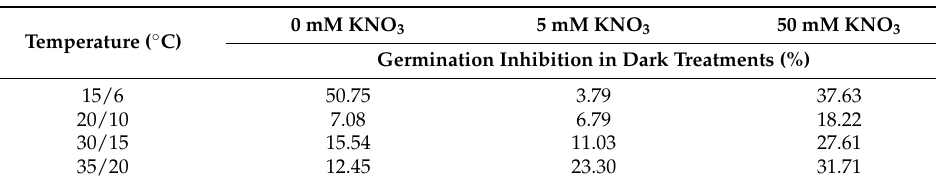
Table 3. Germination inhibition in dark treatments.